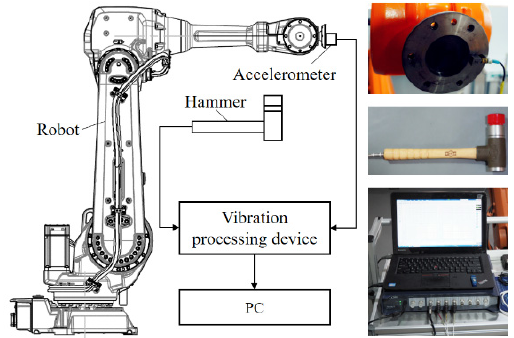
Figure 5. The setup of experimental modal test (EMT) system.